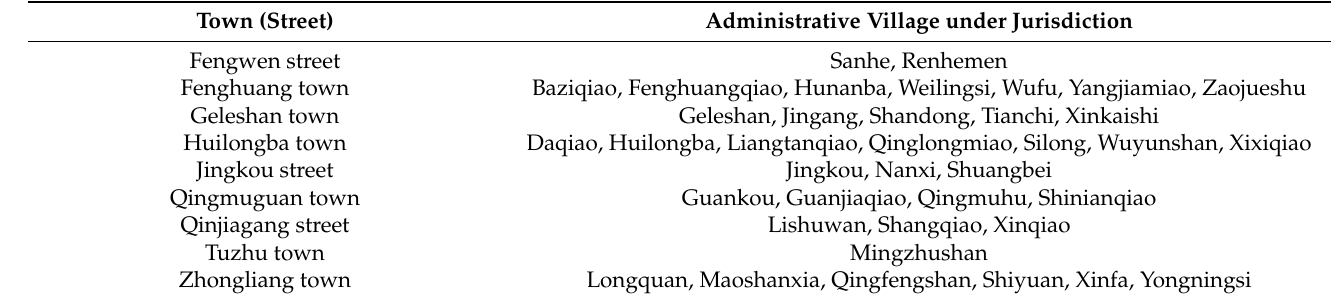
Table 1. Administrative villages requiring planning in Shapingba District. Town